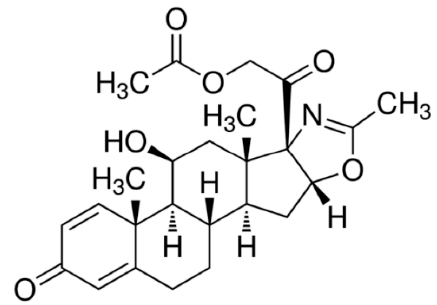
Figure 1. Chemical structure of deflazacort.